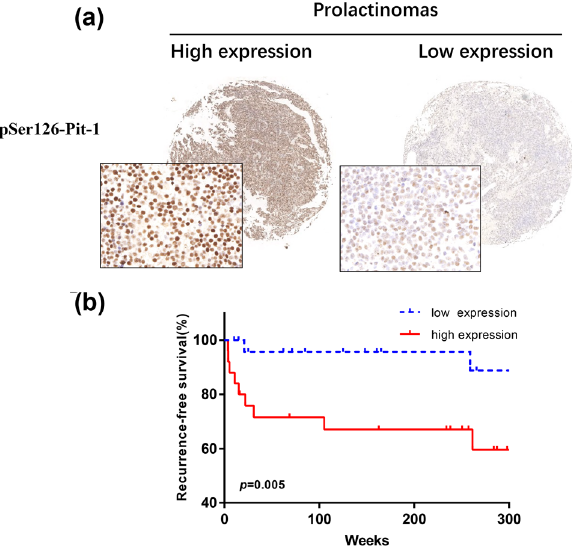
Figure 4: pSer126 - Pit - 1 is associated with poor prognosis. ( a ) Representative images of pSer126 - Pit - 1 staining of a tissue micro - array, including high pSer126 - Pit - 1 levels ( left panel ) and low pSer126 - Pit - 1 levels in prolactinomas ( right panel ) . Insets show 200 × magni fi cations of the low - power images, scale bar, 50 μ m. ( b ) Signi fi cant di ff erences in recurrence - free survival are shown based on pSer126 - Pit - 1 expression status in 48 patients after surgical removal of prolactinomas, *, P <